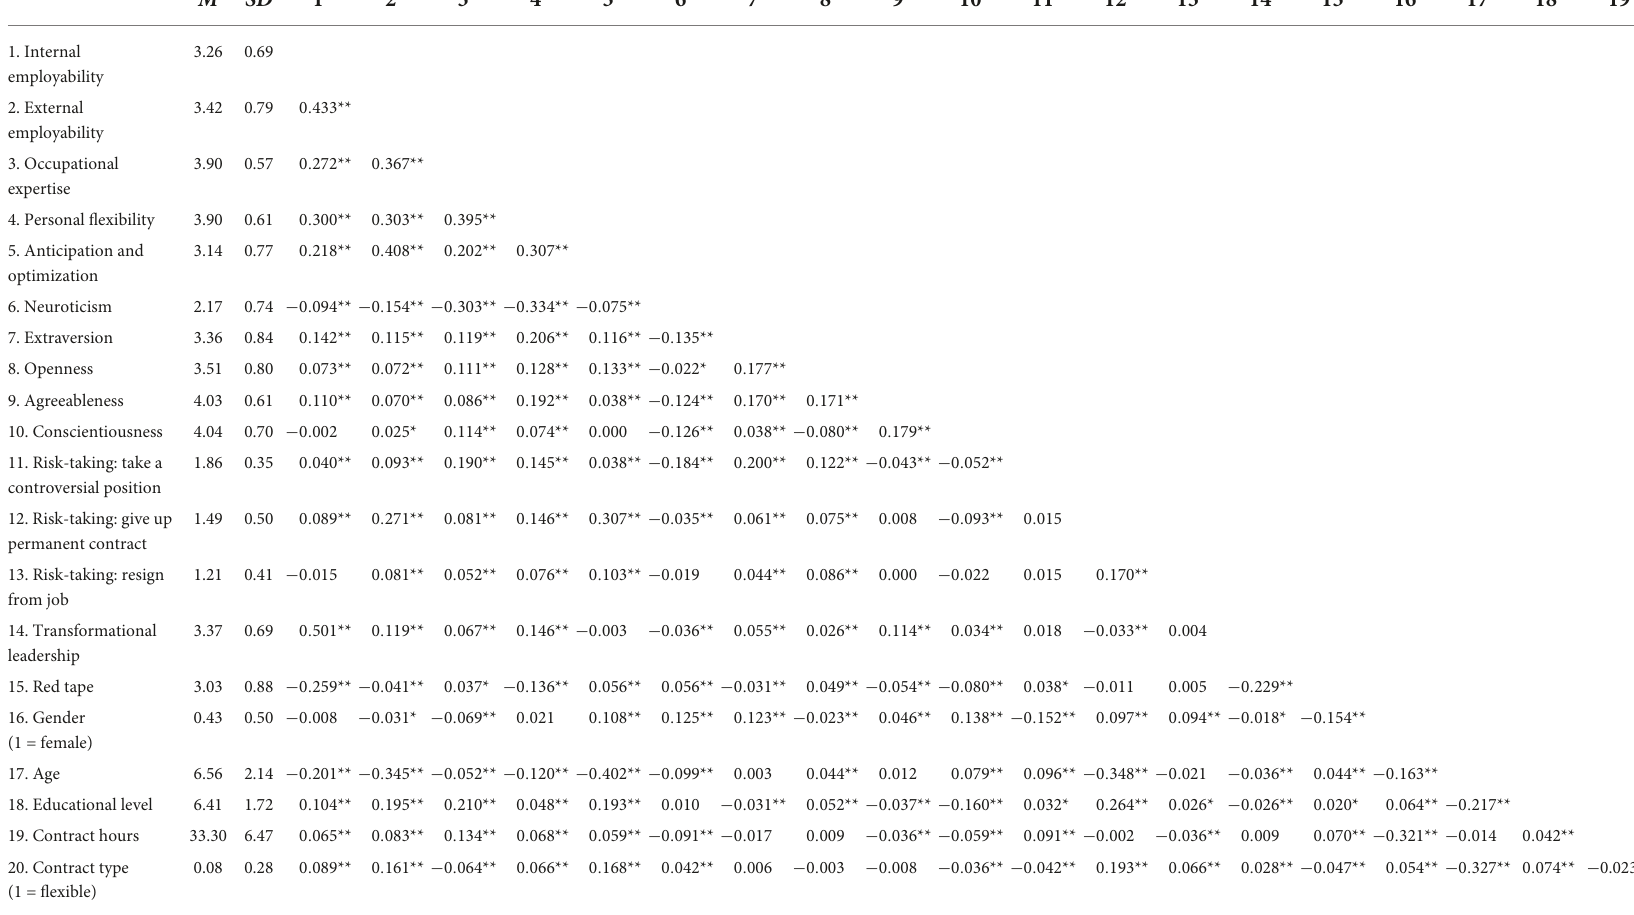
TABLE 1 Means ( M ), standard deviations ( SD ), and